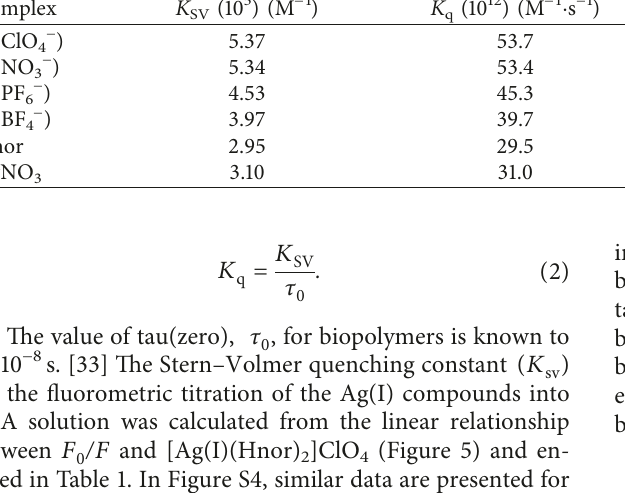
Figure 5: Fluorescence emission spectra of HSA (5 µ M) in the presence of various concentrations of (a) [Ag(I)(Hnor) 1 +extra KClO 4 , and (b) [Ag(I)(Hnor) 2 ]NO 3 compound 2 +extra KClO 4 corresponding to compound concentrations of 1.0, 2.0, 4.0, 7.5, and 10 µ M, respectively, when excited at 295nm. Table 1: Stern–Volmer quenching constants and bimolecular quenching rate constant for the interaction of HSA with four Ag(I) Hnor compounds.